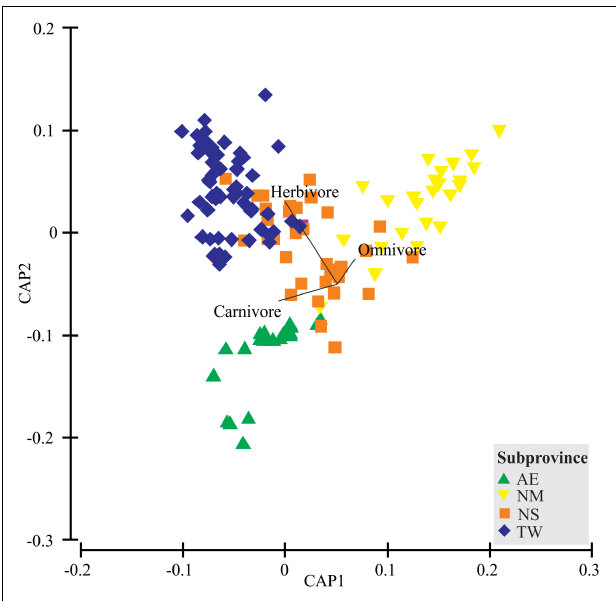
FIGURE 4 | Plot of the canonical analysis of principal coordinates (CAP) generated from the Bray-Curtis similarity matrix of species composition using “subprovince” as the predictor factor. Vector overlay denotes feeding categories with a Spearman rank correlation of above 0.7. Subprovinces: AE, Amazon estuary; NM, Northern mangrove; NS, Northeastern semiarid; TW, Tropical warm.